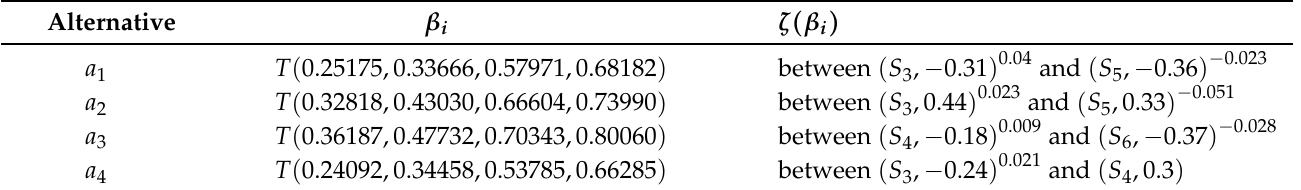
Table 3. The overall result upon “ majority opinion